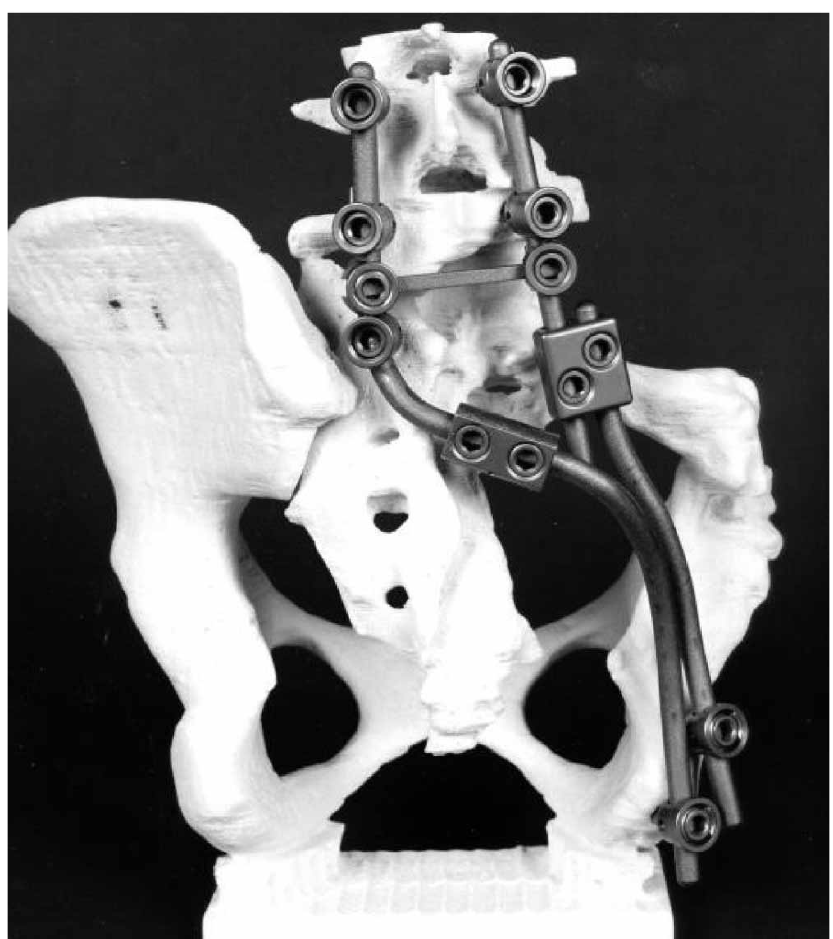
Fig. 4. 3-D reconstruction of the situation after the first operation: the model was used to plan the second operation. A spinal fixator was bent to the model, and two ischial screws were used to close up the pelvic ring.